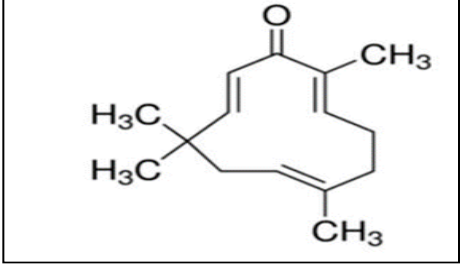
Figure 1. Structure of zerumbone [38].